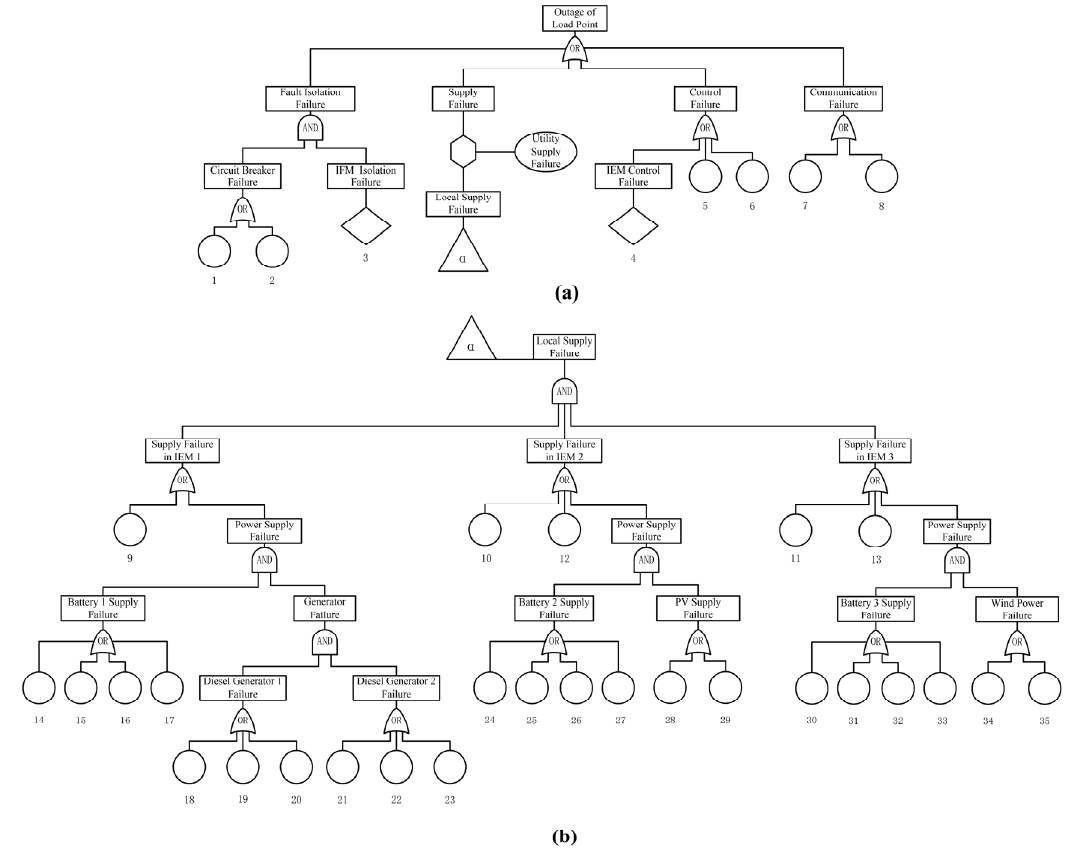
Figure 7. Fault tree showing key events leading to outage of a load point in IEM 1: ( a ) Primary fault tree; ( b ) Secondary fault tree.